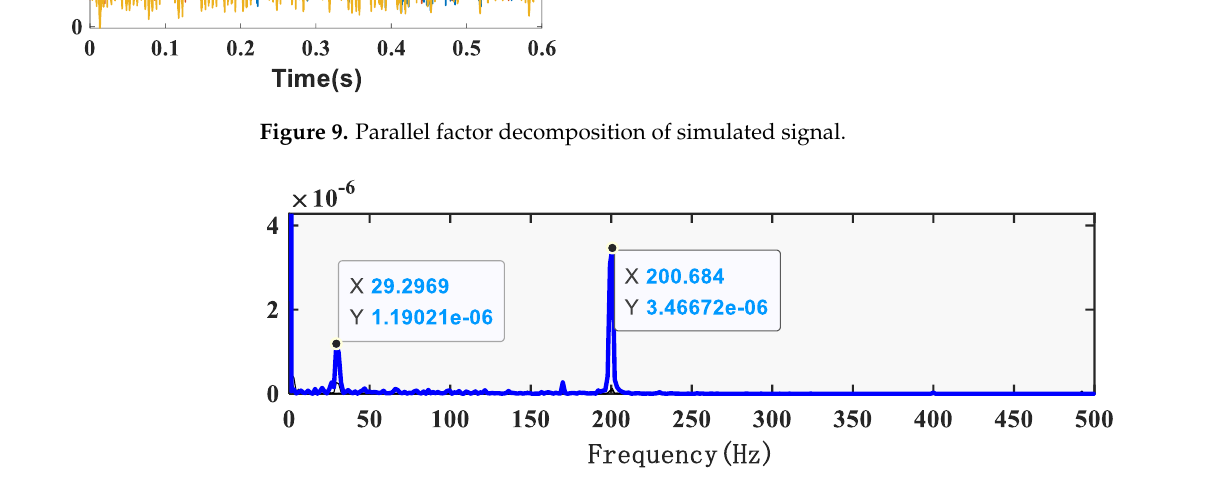
Figure 10. Power spectrum of decomposed time domain loading matrix with PARAFAC.